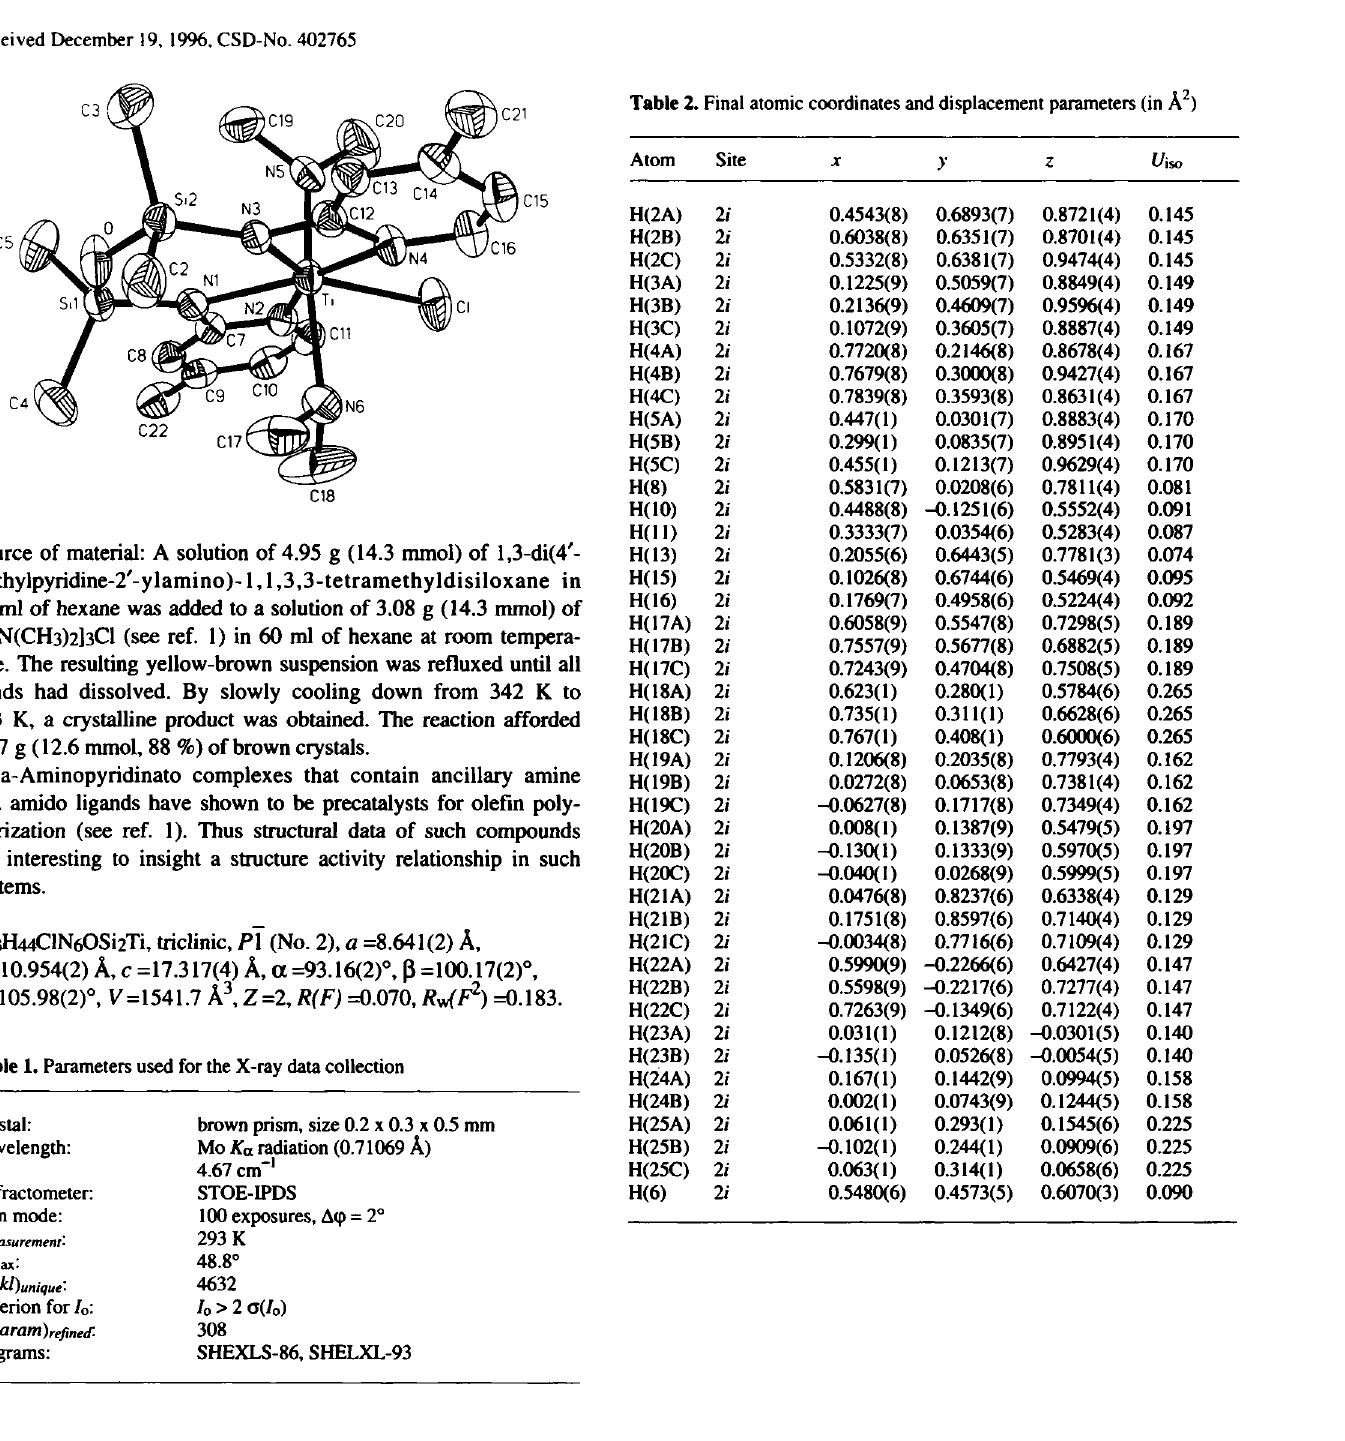
Table 2. Final atomic coordinates and displacement parameters (in Ä 2